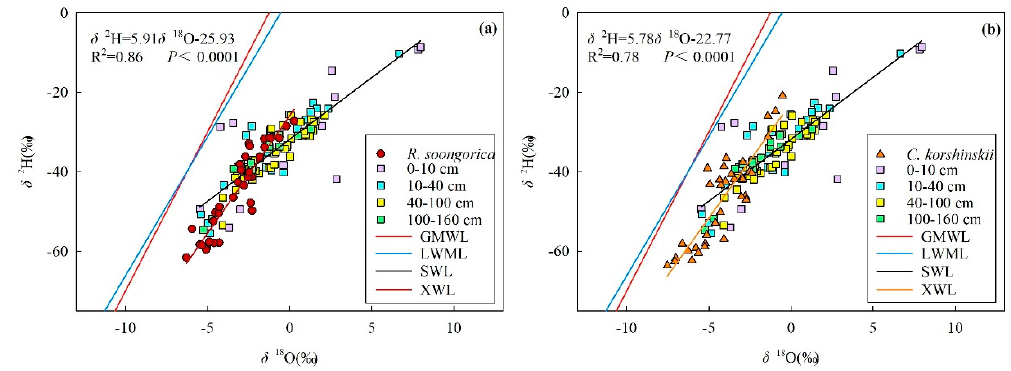
Figure 7. The linear regression relationship between δ 2 H and δ 18 O in xylem water from two species, ( a ) R. soongorica and ( b ) C. korshinskii , during the sampling periods. XWL represents xylem water line based on isotopic data of xylem water. The xylem water line (XWL) was δ 2 H = 5.91 δ 18 O − 25.93, R 2 = 0.86, P < 0.0001 and δ 2 H = 5.78 δ 18 O − 22.77, R 2 = 0.78, P < 0.0001 for R. soongorica and C. korshinskii , respectively. SWL, LMWL and GMWL are plotted in each panel for reference. The isotopic compositions of soil water are shown in the figure.